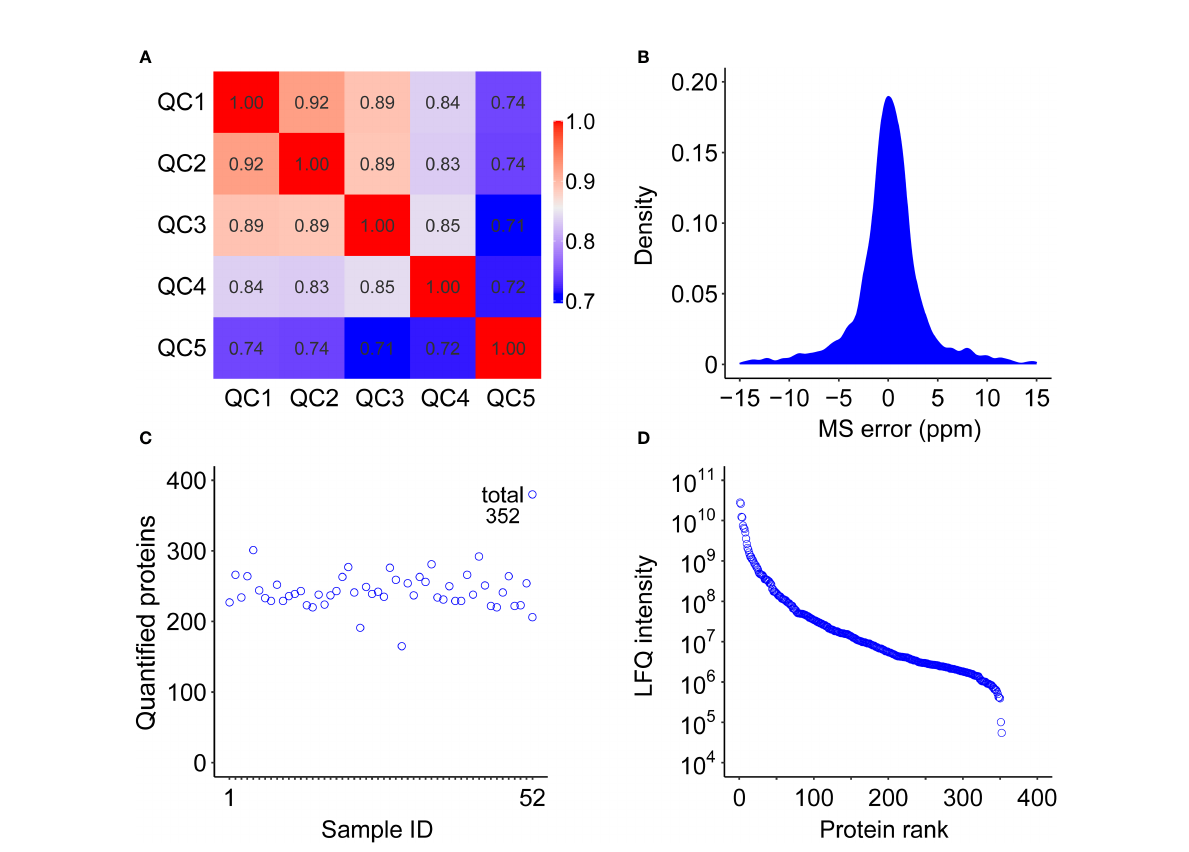
FIGURE 2 Quality control of the serum EV proteome study from cohort 1. (A) Correlation coef fi cient map of QC samples. (B) Distribution of mass error of the identi fi ed peptides. (C) Numbers of identi fi ed proteins in each of the 52 samples in cohort 1. (D) Dynamic range of quanti fi ed proteins using LFQ (label-free quanti fi cation) intensity